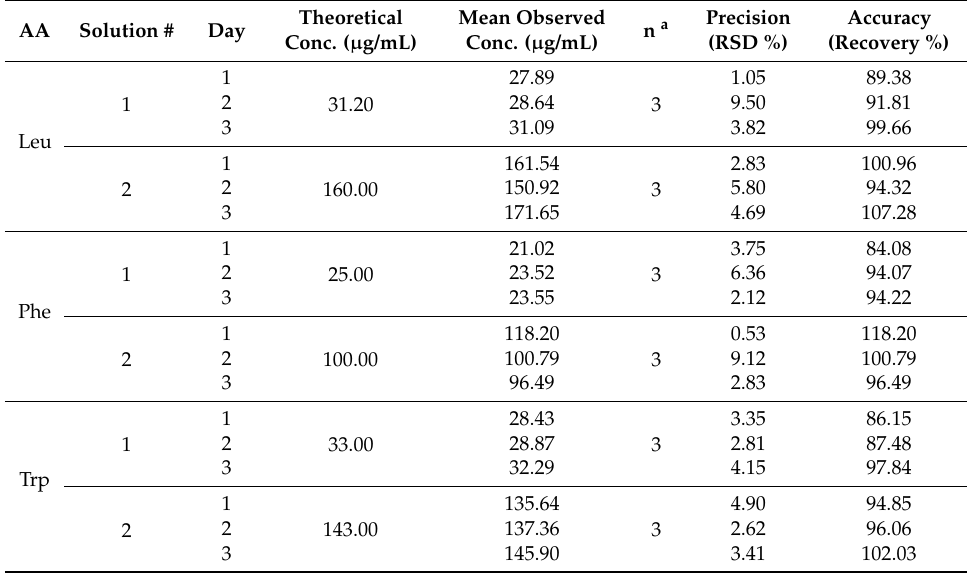
Table 2. The statistical analysis of the three selected amino acids in the short period (intra-day precision and accuracy values).